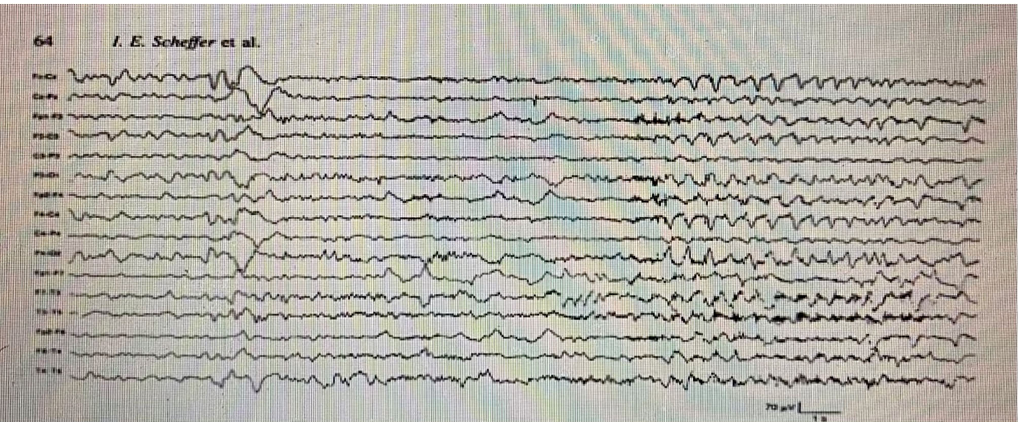
Figure 26. Hereditary frontal lobe epilepsy. The figure shows a seizure in NREM sleep which is of frontal lobe origin. The patient deviates the head and eyes and lifts the arm. The majority of patients with hereditary frontal lobe epilepsy do not show EEG discharges. This is consistent with the belief that the epileptogenic focus is in the supplementary motor area on the mesial face of the frontal lobe. (Adapted from Scheffer et al. in the article “Autosomal dominant nocturnal frontal lobe epilepsy: a distinctive clinical disorder. Brain 1995, 118: 61–73. Permission to reproduce granted by Oxford Uni ‐ versity